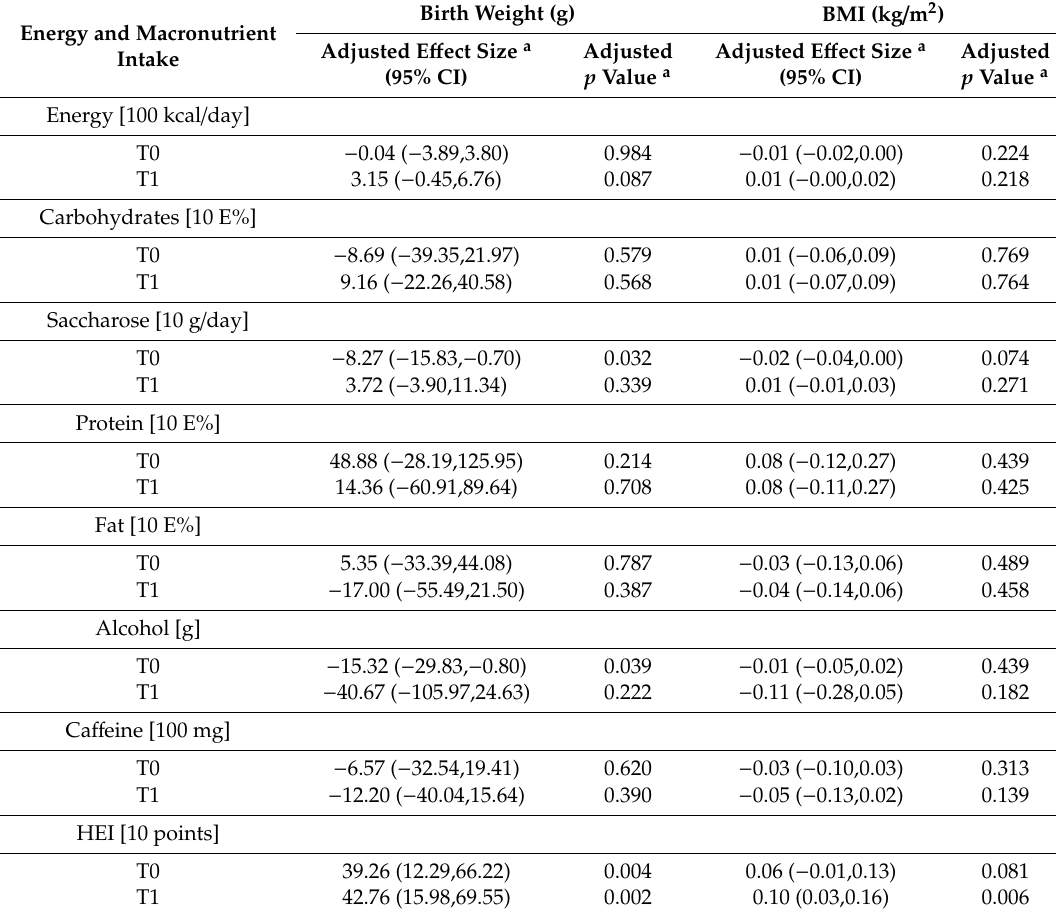
Table 4. Associations between maternal energy, macronutrient intake and dietary quality and o ff spring birth weight and body mass